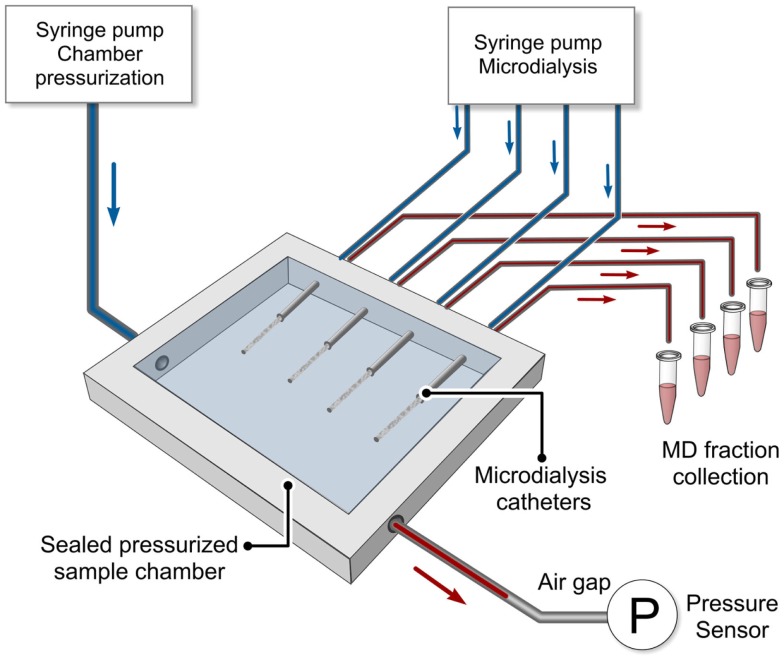
Schematic drawing of a pressurized in vitro MD sampling system is shown. The chamber held four MD catheters and was used to study the impact of different pressures present in a MD sampling system on fluid recovery (42). Pressure parameters tested included perfusion flow rate, colloid osmotic additives in both perfusate and sample, and static outside pressure. The precision of the system was <0.5 mmHg and pressures could be set accurately in order to simulate different NIC conditions [adopted from Ref. (42)].